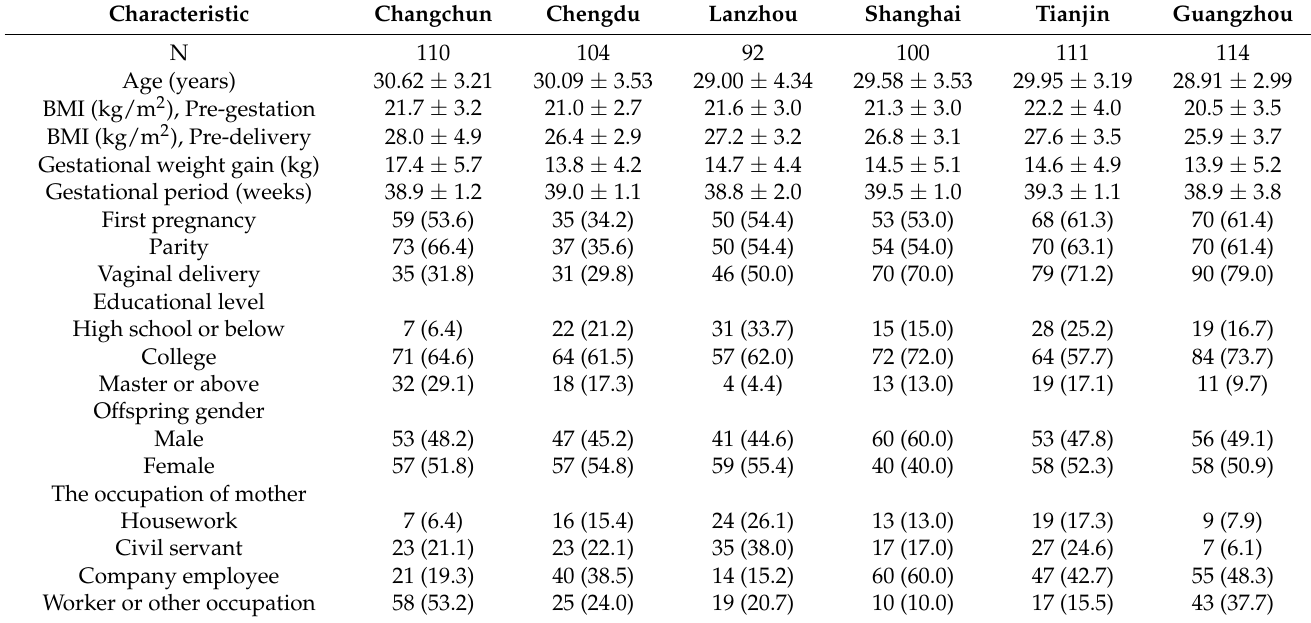
Table 1. Basic demographic characteristics of lactating mothers and respective newborns in six regions.